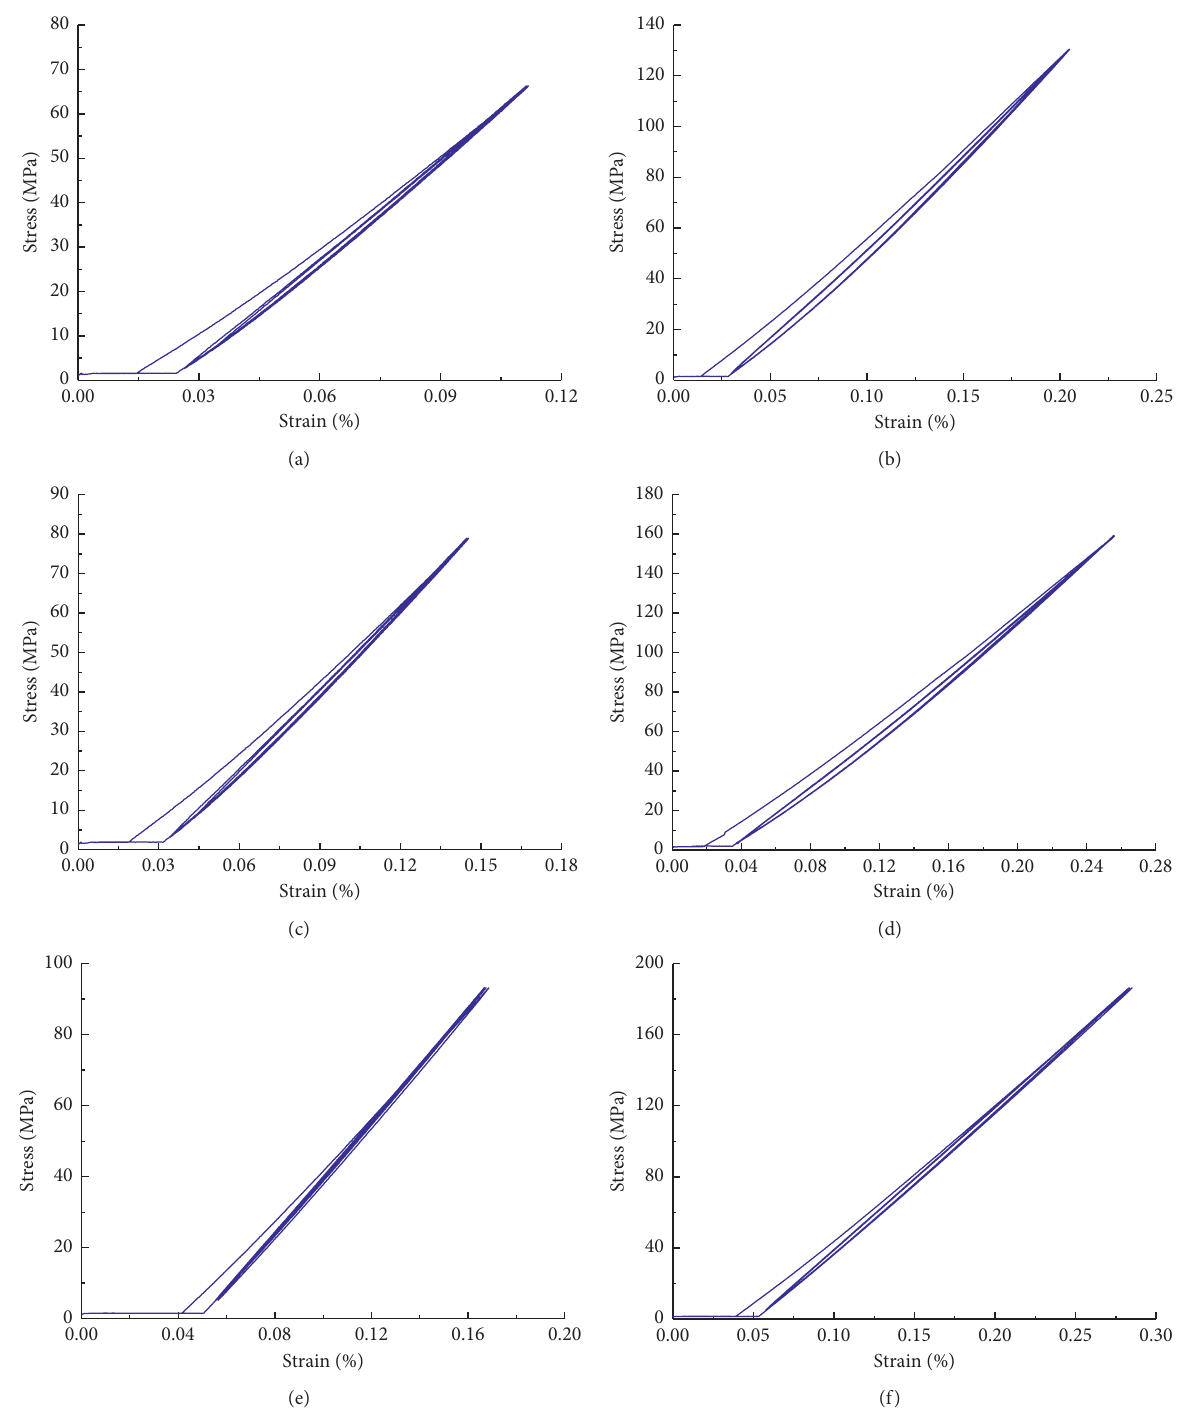
Figure 9: Typical stress-strain curves under different fixed values and confining pressures: (a) 20% σ P and 10MPa; (b) 40% σ (c) 20% σ P and 20MPa; (d) 40% σ P and 20MPa; (e) 20% σ P and 30MPa; (f) 40% σ P and